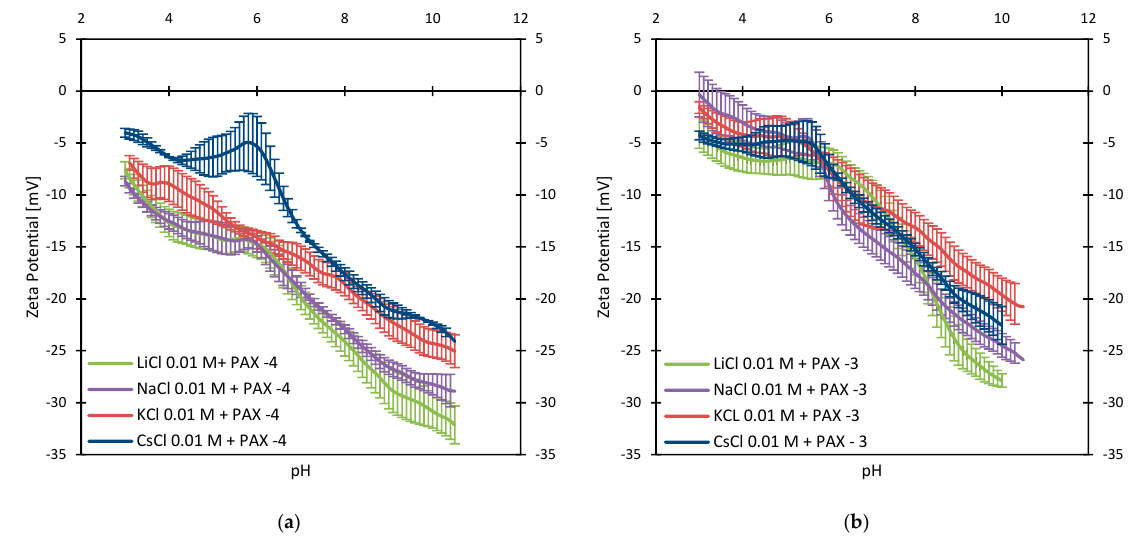
Figure 7. Zeta potential of pyrite as function of pH for different chloride salts at two concentrations of amyl xanthate (PAX) ( a ) 10 − 4 M ( − 4) and ( b ) 10 − 3 M ( − 3).